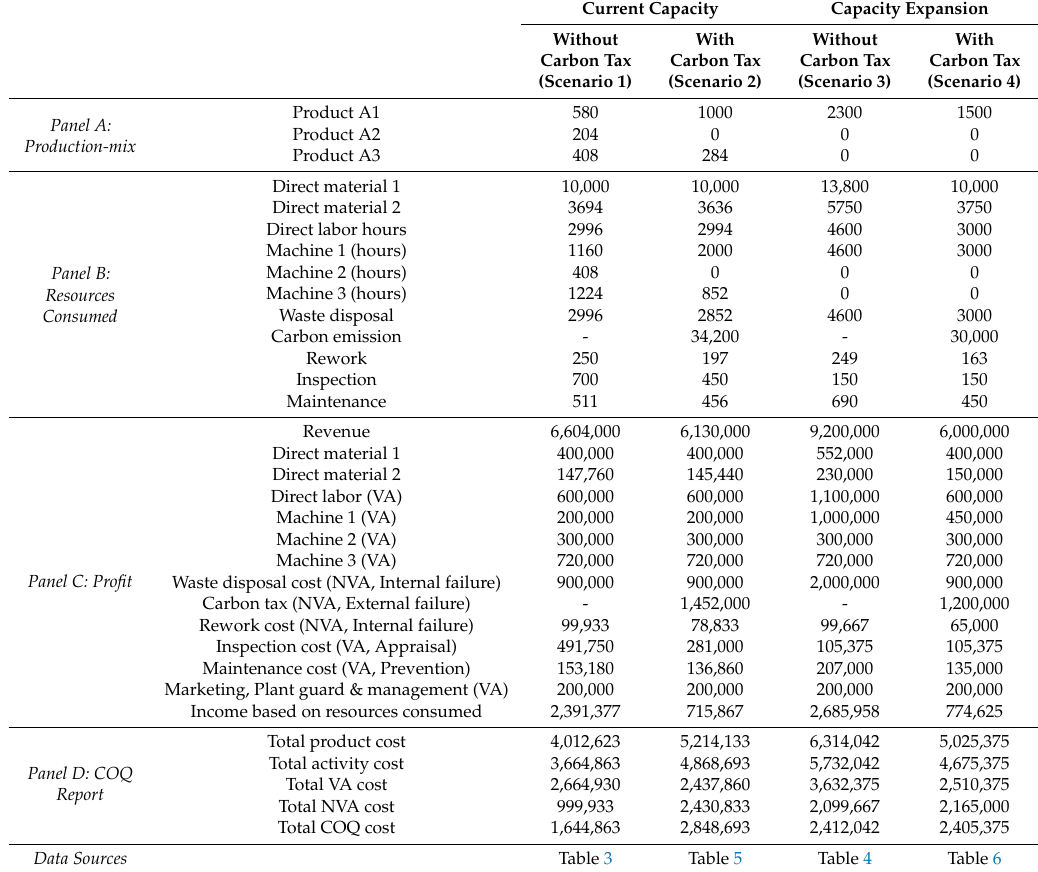
Table 7. Green quality management report for comparison of the four decision